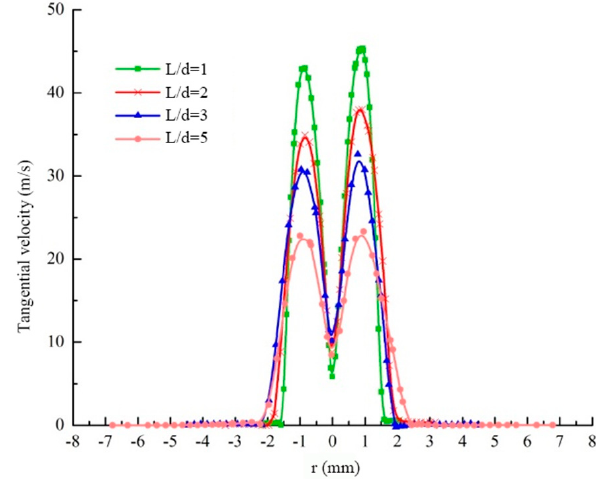
Figure 6. Tangential velocity distribution under variant dimensionless jetting distance.